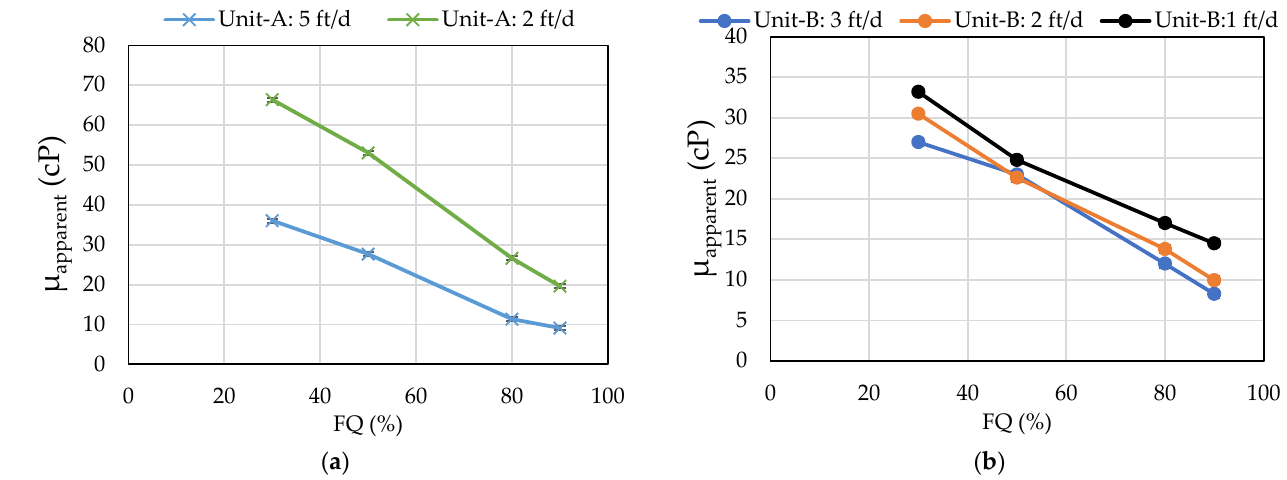
Figure 6. Apparent viscosity in ( a ) Unit-A Exp 1, and ( b ) Unit-B Exp 1 as a function of FQ for injection rates varying from 1 – 5 ft/d.